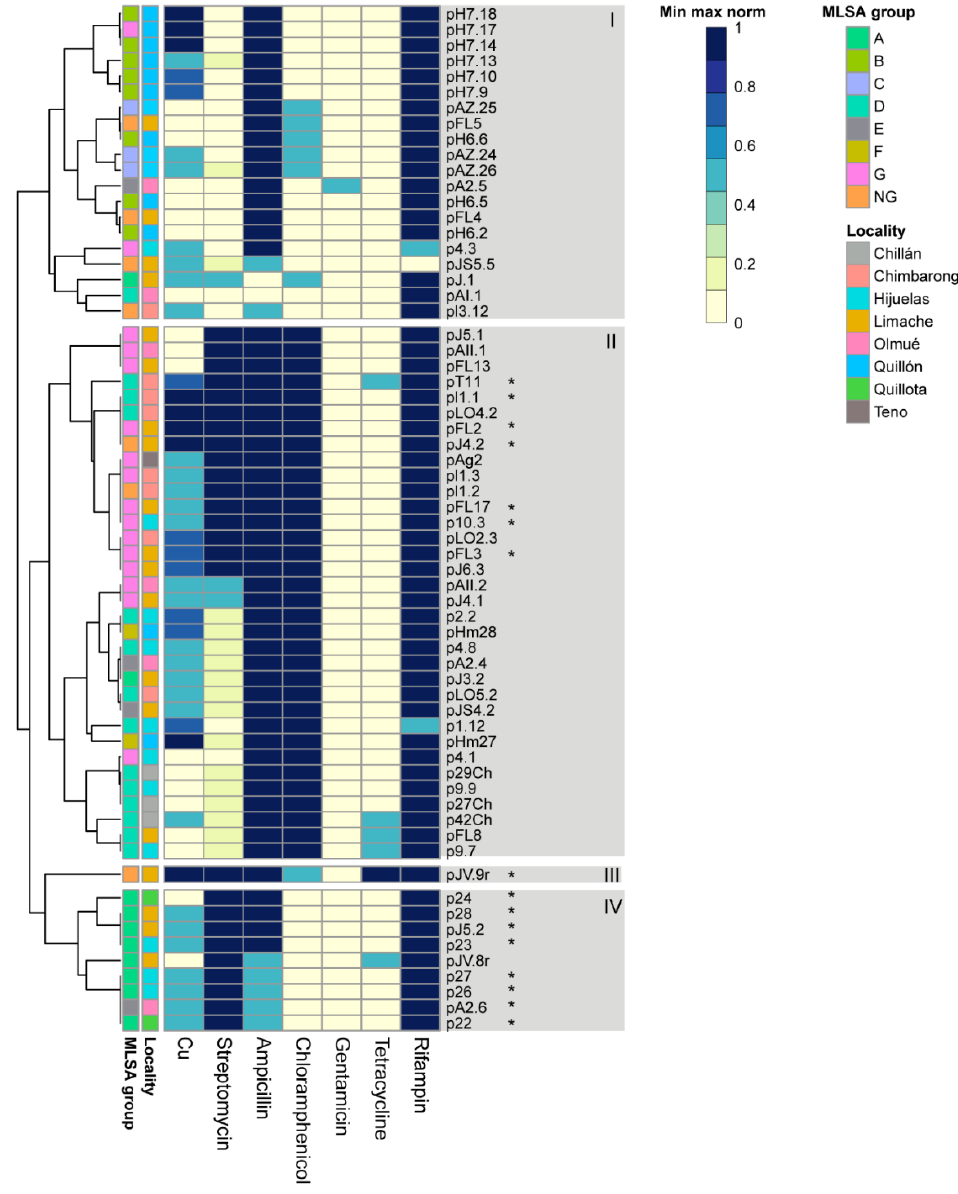
Figure 4. Heat map representation of Pseudomonas isolates antimicrobial susceptibility. The vertical axis contains the bacterial isolates which were clustered according to their susceptibility to the different antimicrobials (Clusters I–IV). In the case of Cu and streptomycin, both dark and light blue colored squares represent resistant phenotypes (with different MIC). For remaining antimicrobials, only dark blue represents resistant phenotype. Asterisks (*) highlight isolates classified as highly resistant to streptomycin ( MIC ≥ 200 μg /mL). Isolation location and the genetic cluster to which they belong according to the MLSA analysis are also displayed.